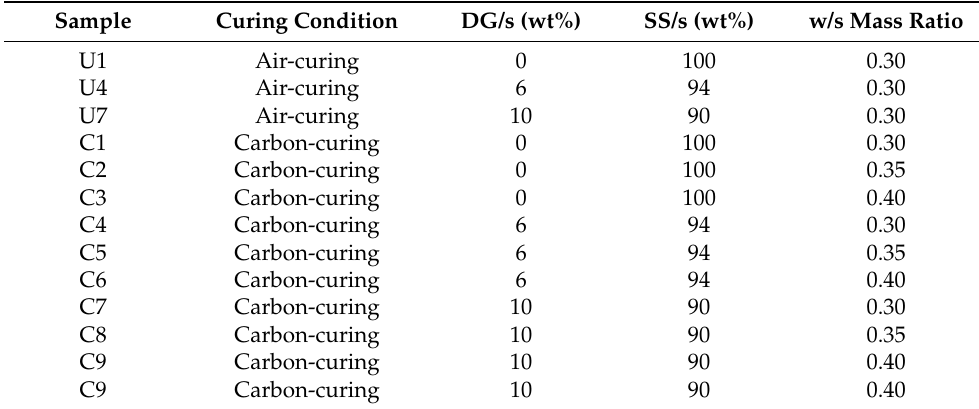
Table 2. Mix proportions and curing conditions of the